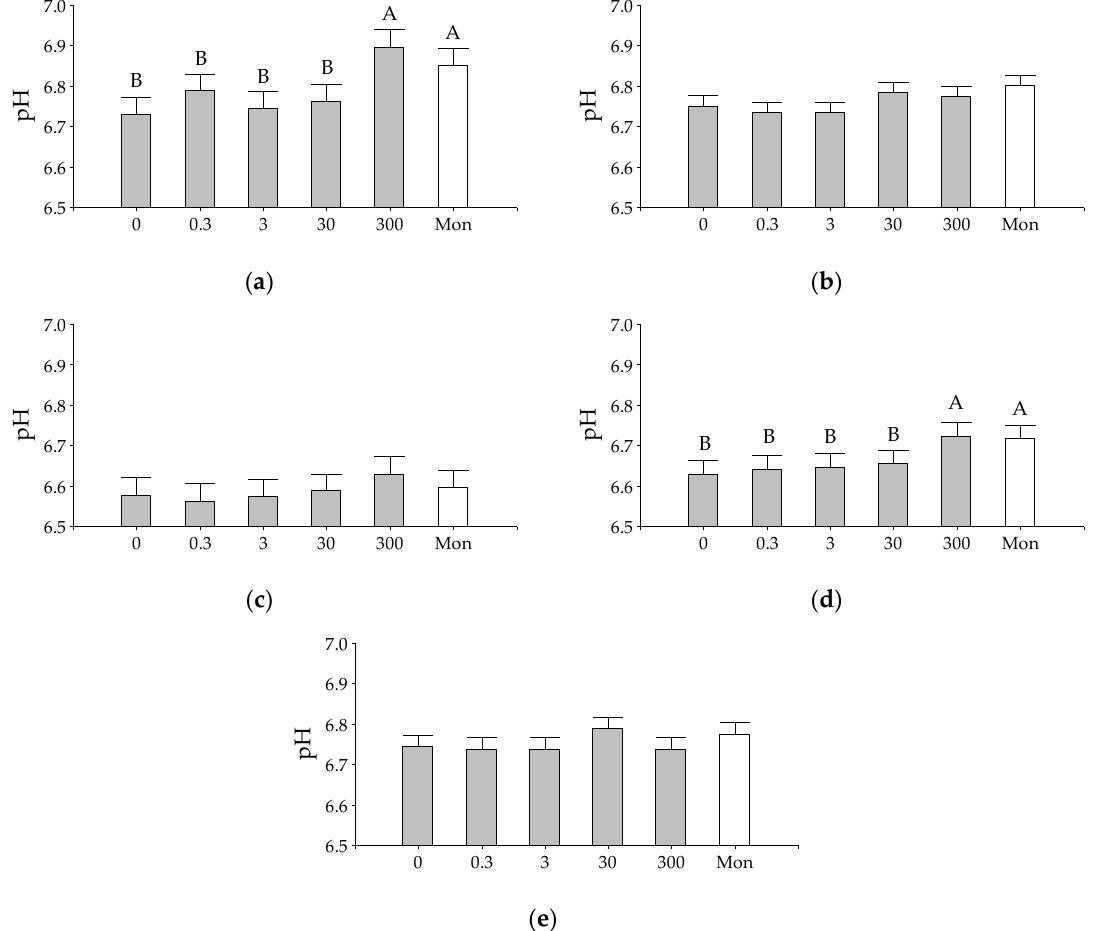
Figure 2. Effect of increasing doses (µL/L) of Lippia turbinata or the addition of 1.87 mg/L of monensin on medium pH after 48 h of in vitro incubation for different substrates: ( a ) breeding; ( b ) rearing; ( c ) fattening; ( d ) dairy, and ( e ) standard. The bars represent the standard error of the mean. In graphs ( a ) and ( d ), A,B different letters indicate statistically significant differences between substrates (DGC, p - value < 0.05).